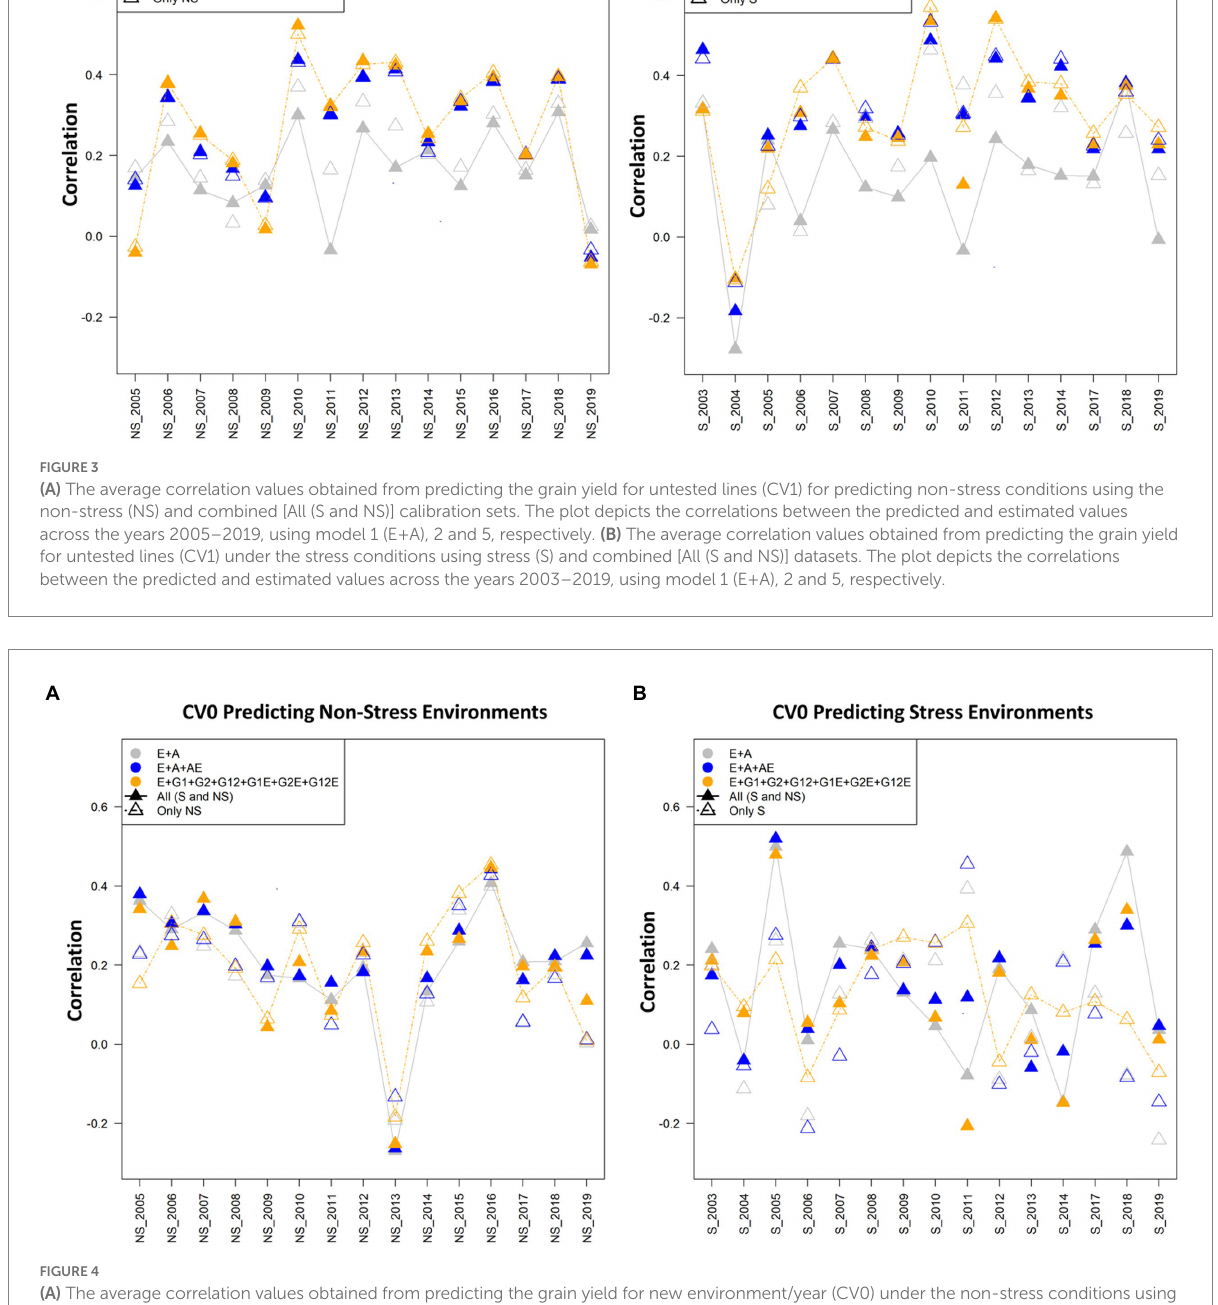
(E + GCA + SCA + GCA × E + SCA × E). The added interaction